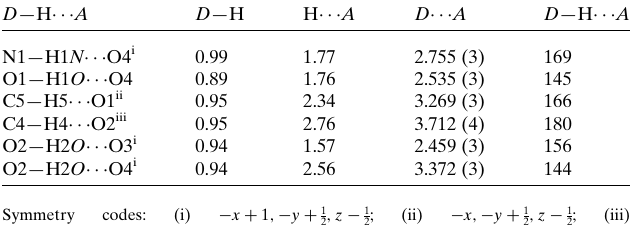
Table 2 Hydrogen-bond geometry (A˚ , (cid:5) ) for II .